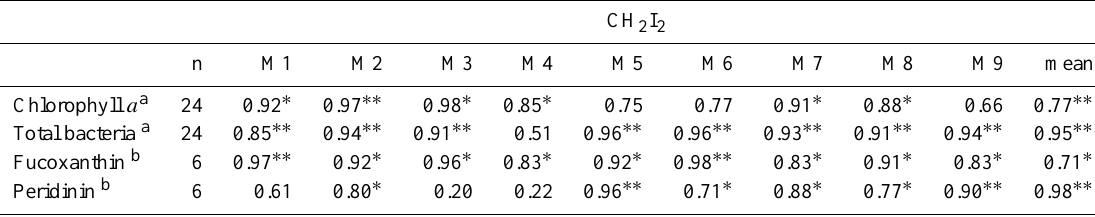
Table 5. Correlation coefficients ( R ) for relationship between CH 2 I 2 (pmolL − 1 ) and chlorophyll a , total bacterial abundance, and phyto- plankton pigments(fucoxanthin and peridinin). Asterisks indicate associated probability: ∗ p < 0.05, ∗∗ p < 0.01.